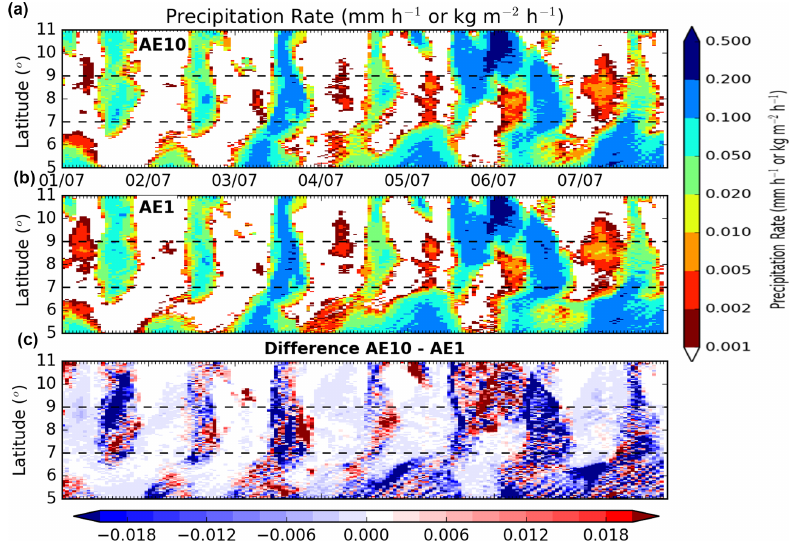
Figure 13. Time–latitude average (Hovmoller) of hourly precipitation rate (kgm − 2 ) for the two experiments (a) AE10 and (b) AE1, and (c) the difference (AE10 − AE1) averaged over an area extending from 1 to 4 ◦ E during the period 1–7 July